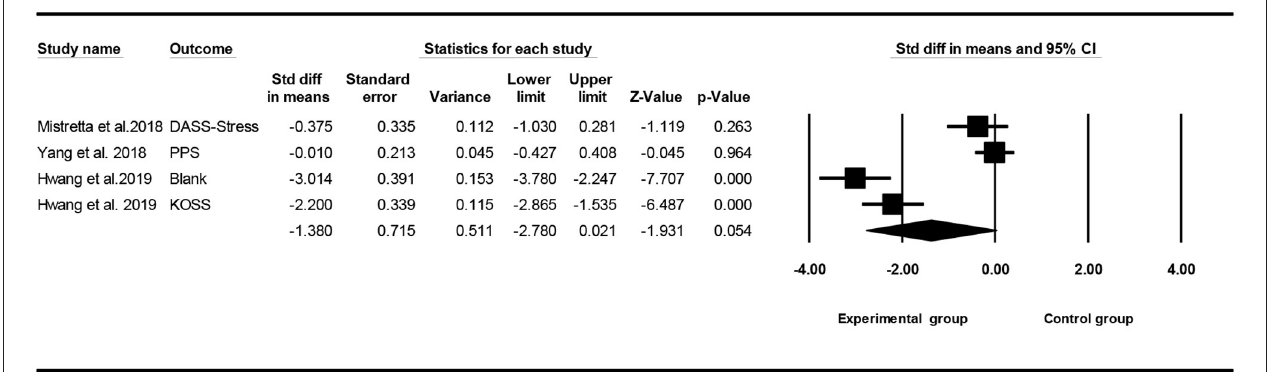
FIGURE 10 | Forest plot for